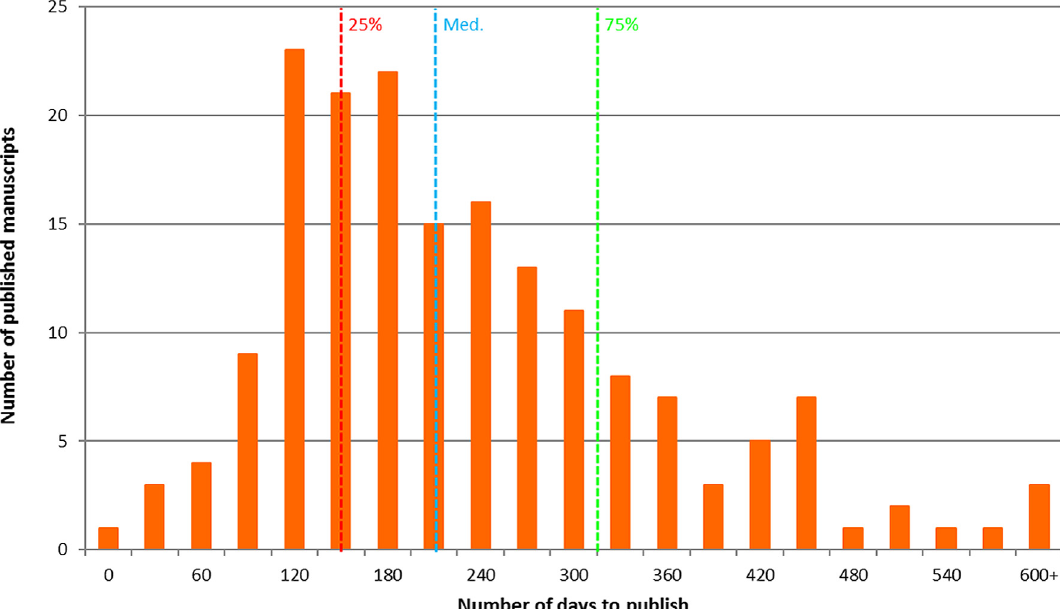
Fig. 3. The number of published manuscripts plotted versus the number of days required from submission to online publication (handling time). The figure presents the status on 10 December